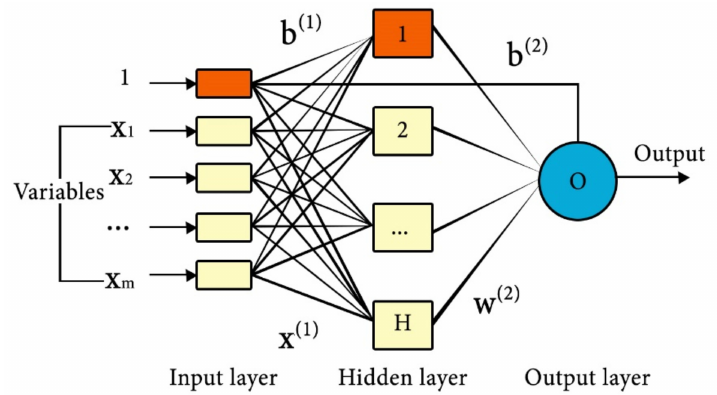
Figure 4. A typical architecture of a multilayer neural